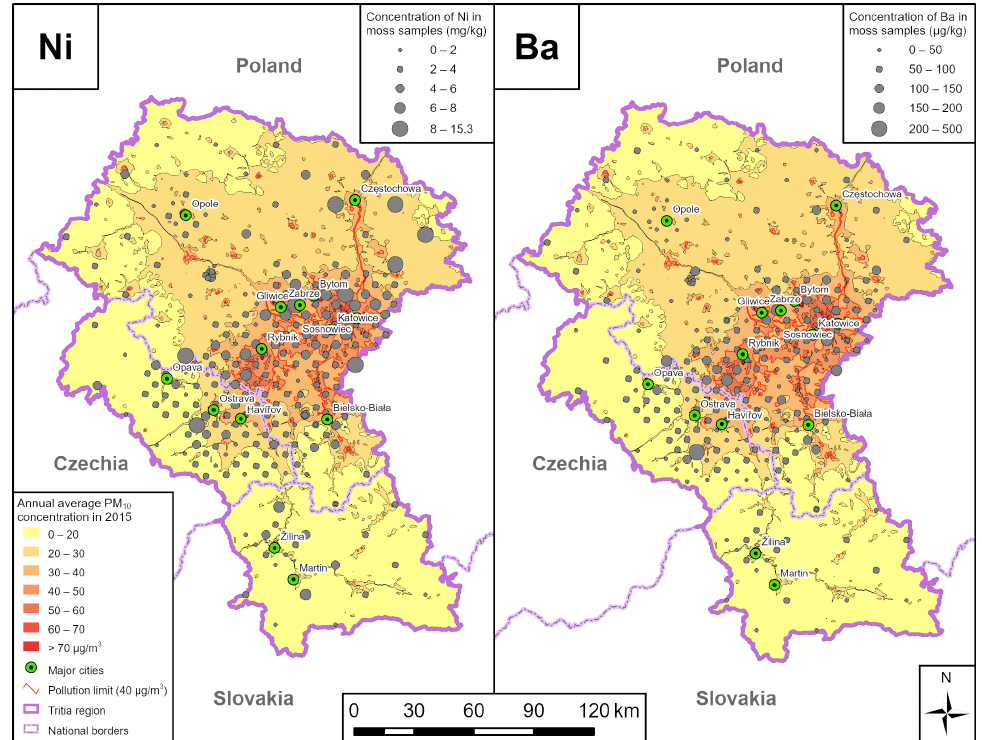
Figure 8. Ni and Ba concentrations determined by INAA in mosses and ADMOSS results